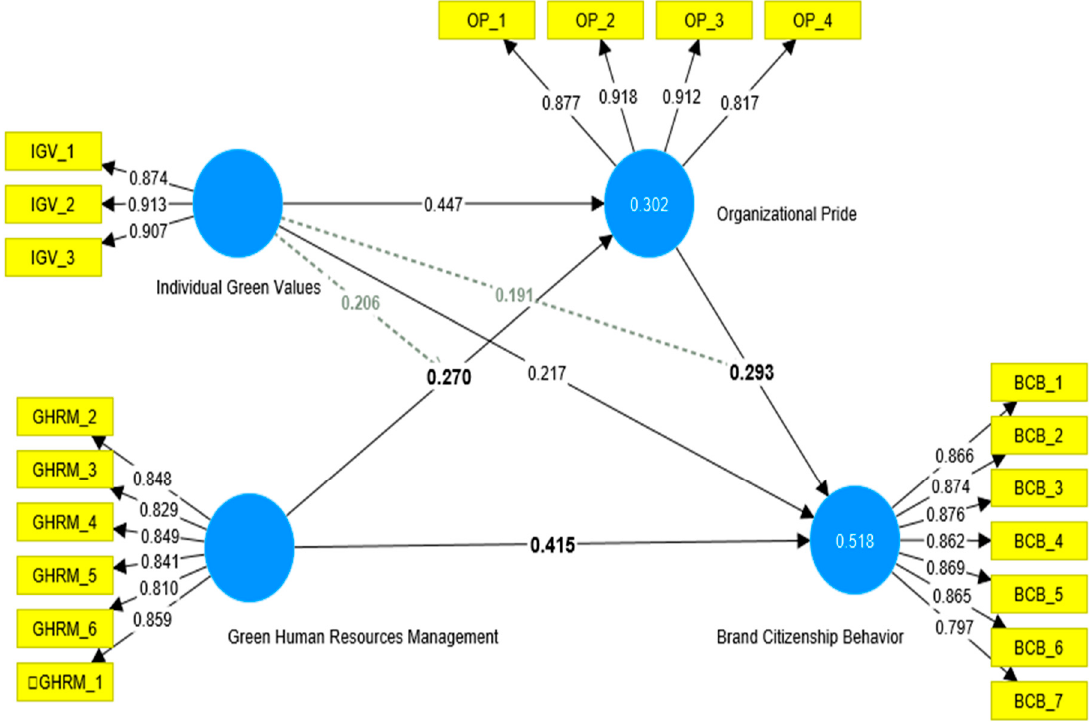
Figure 2. The study